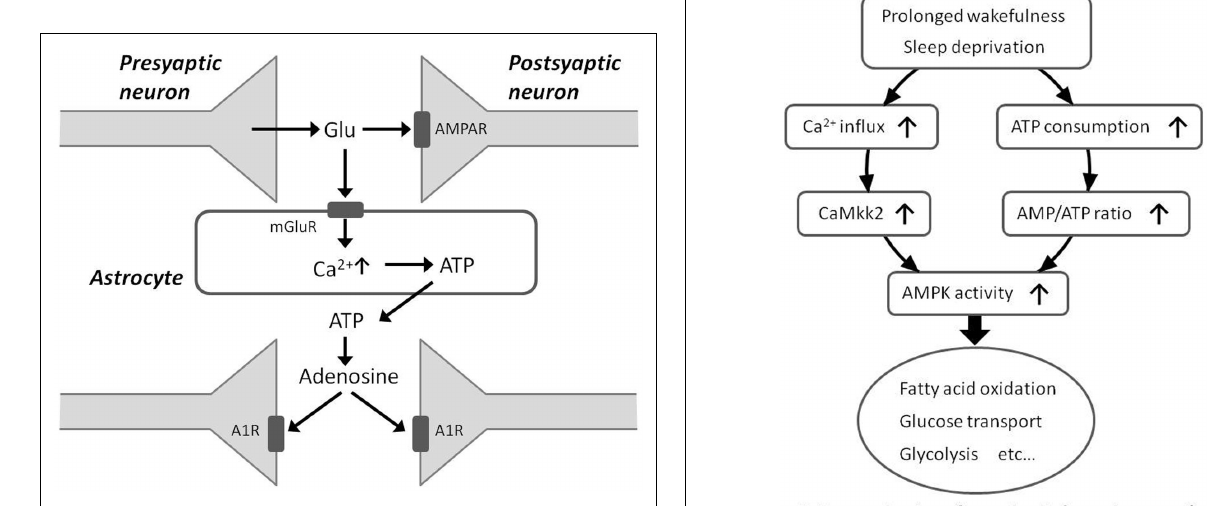
activates central AMPK via decreased AMP/ATP ratio or increased CaMkk2 expression. An activation of AMPK enhances energy-producing catabolic pathways and attenuates energy-consuming anabolic